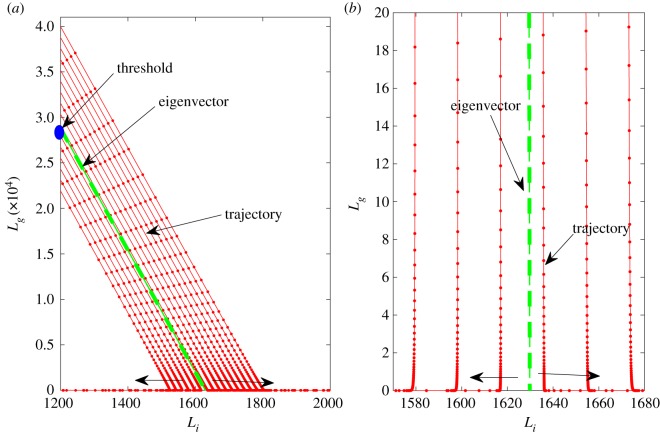
Demonstration of the behaviour of trajectories and significance of threshold (3.4) to determine the destination of trajectories. Trajectories starting above (below) the threshold travel parallel to the eigenvector (3.3), then along the Li-axis, approaching the steady state L+ (L0). (a) The full view and (b) a magnified view near the Li-axis.